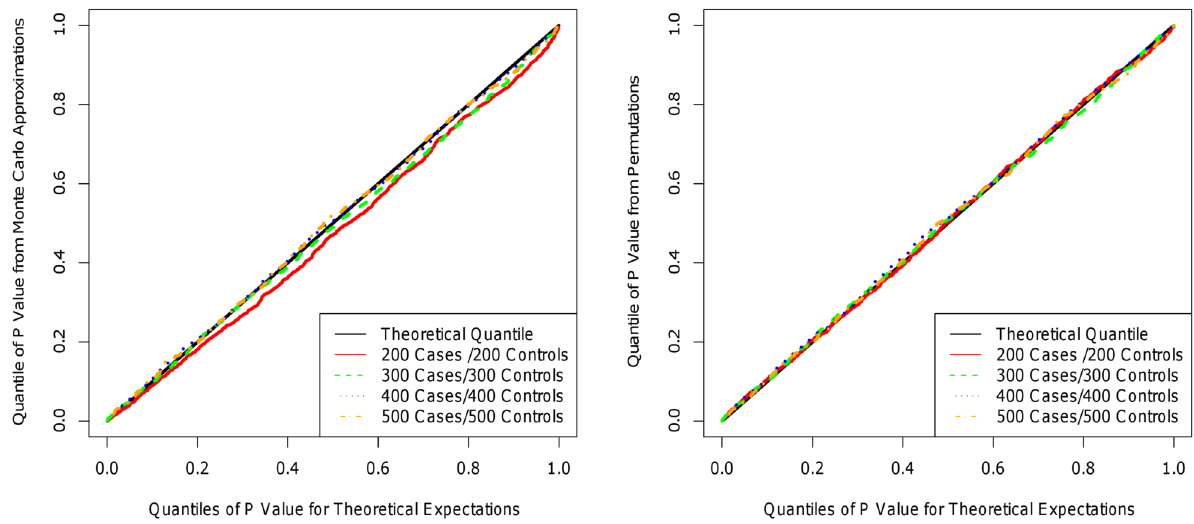
permutation, respectively. Four sample sizes were investigated: 200 cases/200 controls; 300 cases/300 controls, 400 cases/400 controls, and 500 cases/500 controls. A total of 3,000 replicates were used to generate the QQ plot for each sample size.